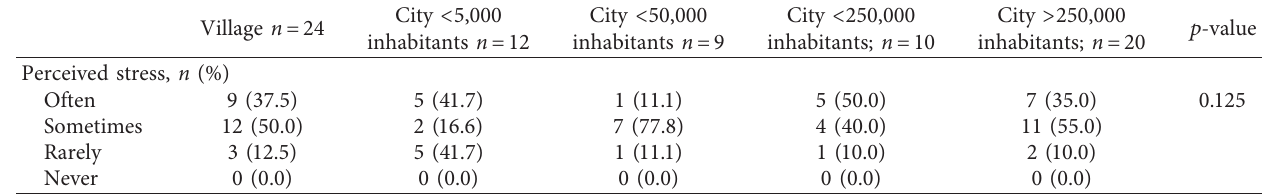
Table 2: Perceived stress due to androgenetic alopecia reported by the surveyed men by the place of living.